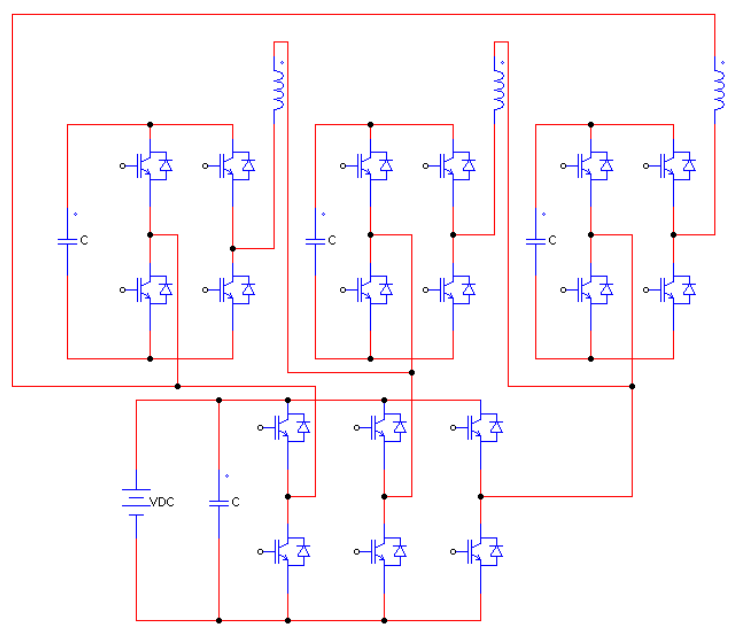
Figure 12. Hybrid three-phase multilevel inverter.